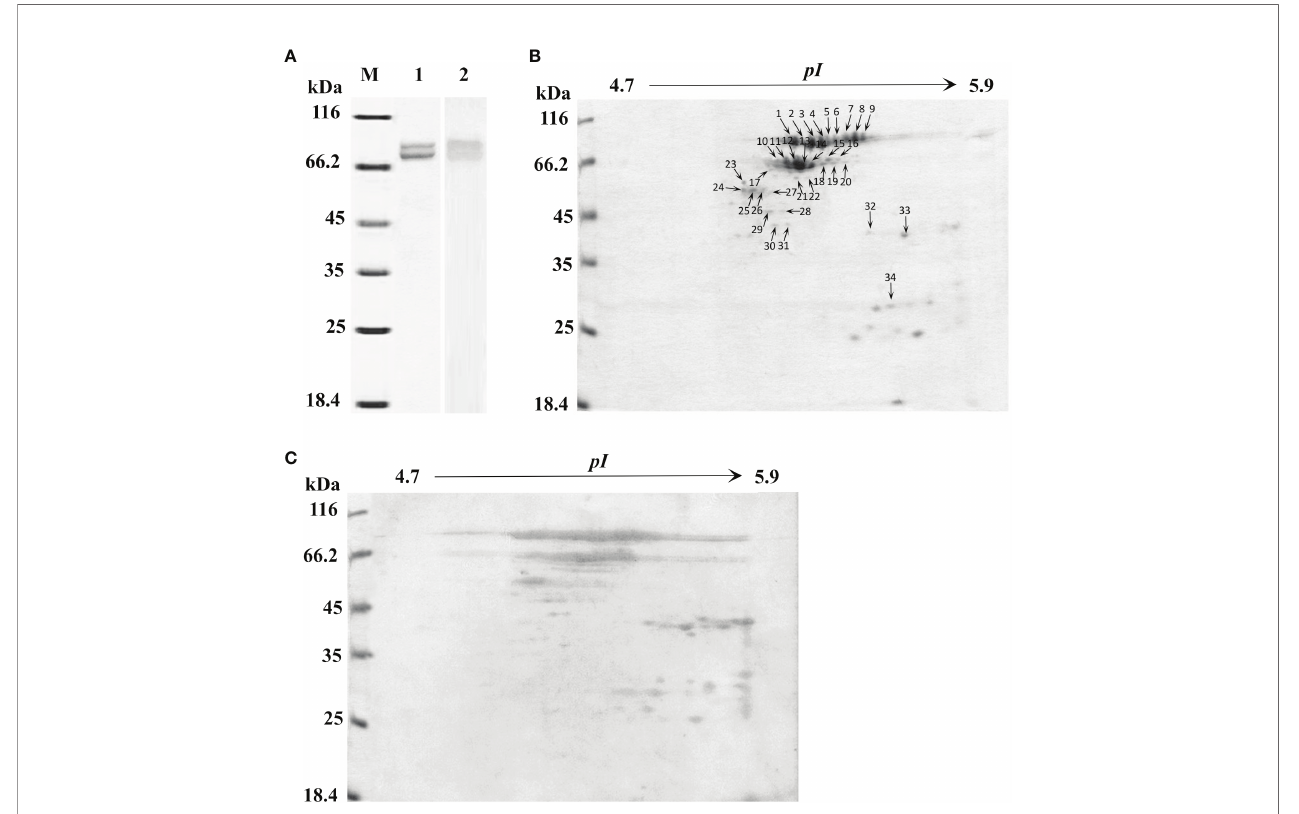
FIGURE 1 | One-dimensional sodium sulfate-polyacrylamide gel electrophoresis (1-DE), two-dimensional polyacrylamide gel electrophoresis (2-DE) and immunoblotting analysis of L. hemocyanin. (A) 1-DE image of L. vannamei hemocyanin puri fi ed by gel- fi ltration chromatography and anion-exchange chromatography (lane 1) and its immunoblotting analysis (lane 2). M, molecular mass markers. Western blotting was performed using rabbit anti-shrimp HMC antisera (1:1,000 dilution) and goat anti-rabbit IgG-HRP (1: 3,000 dilution) antibodies. (B) 2-DE image of 30 µg hemocyanin from (A) with pH 4.7 – 5.9 IPG strips. The spots were excised from 2-DE gels, and submitted to protein identi fi cation by MALDI-TOF-TOF-MS analysis, the spots marked with number indicated that the HMC proteins identi fi ed. (C) Immunoblotting was carried out as the same descriptions with (A)